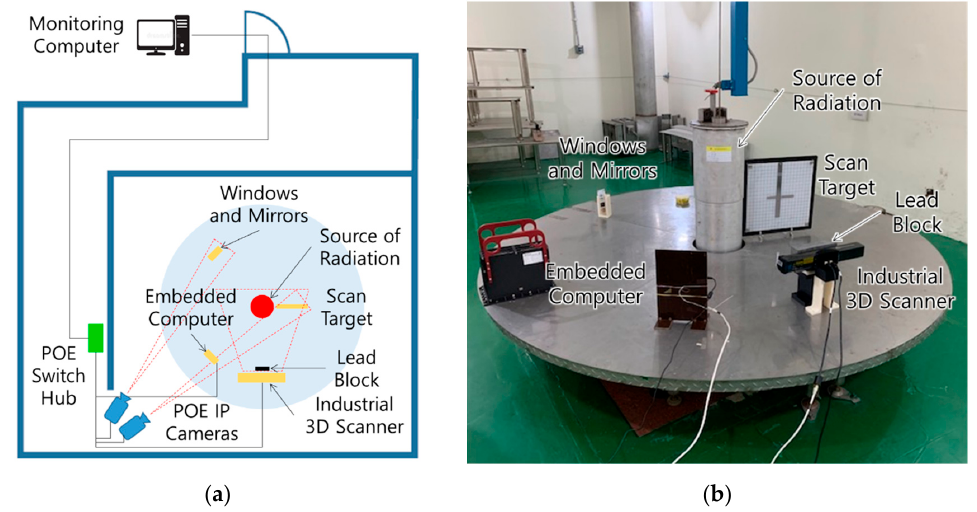
Figure 5. Irradiation Experimental Setup: ( a ) Layout Drawing; ( b ) Irradiation Facility.